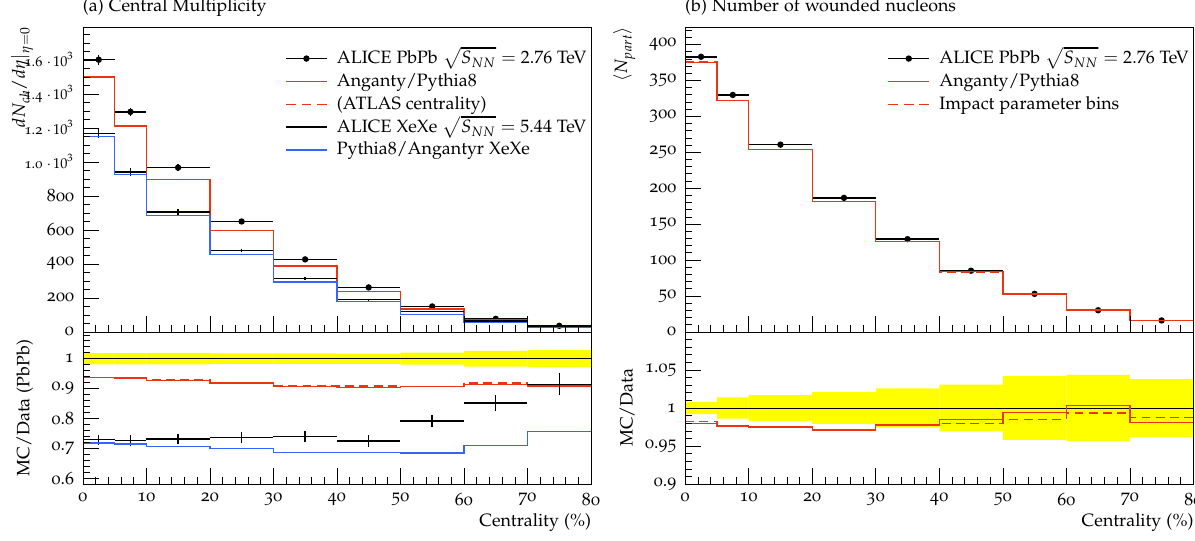
Figure 2. (a) The centrality dependence of the average charged multiplicity in the central pseudo-rapidity bin for PbPb collisions at = 2 . 76 TeV and XeXe collisions at √ s = 5 . 44 TeV. Data points are from ALICE [18] (PbPb) and [19] (XeXe), while red (PbPb) √ s NN NN and blue (XeXe) lines are from Angantyr. (b) Shows the averaged number of wounded nucleons as a function of centrality. The points are from a Glauber-model calculations from ALICE [18], while the red line is the result from Angantyr. For comparison the dashed line, (barely visible under the corresponding full ones) shows the number of wounded nucleons as a function of percentiles in generated impact parameter in